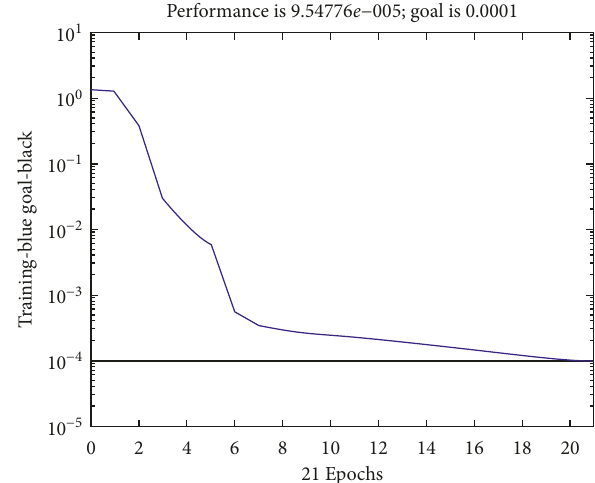
Figure 10: Training performance for the Levenberg–Marquardt backpropagation algorithm of ANN.